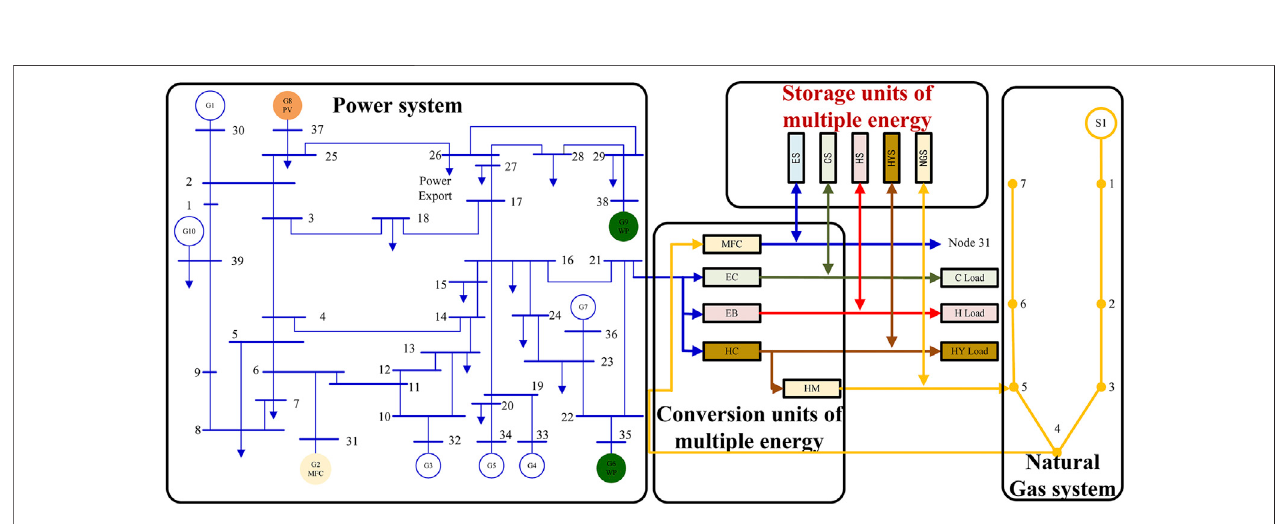
FIGURE 3 | The diagram of simulation system.